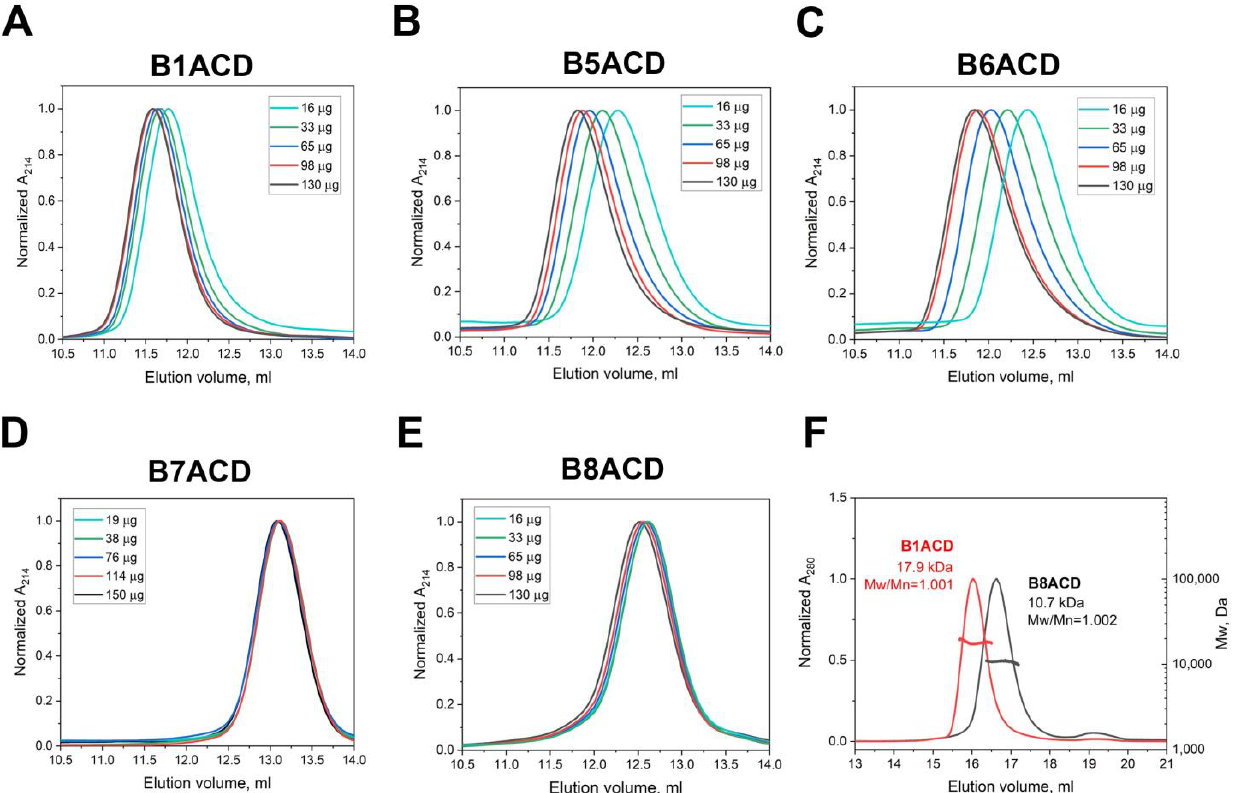
Figure 2. The five sHsp ACDs had markedly different dimer stabilities. ( A – E ) Size-exclusion chromatography of different ACD quantities loaded on a Superdex 75 10/300 column. The quantity of protein loaded on the column is color-coded for each panel. Representative results of no less than three experiments are presented. ( F ) SEC–MALS-derived absolute Mw determination for two contrasting species, B1ACD and B8ACD, run on a Superdex 200 Increase 10/300 column at identical protein load concentrations (2 mg/mL) and volumes (90 µL). Mw distributions are indicated across peaks along with corresponding polydispersity indices (Mw/Mn).